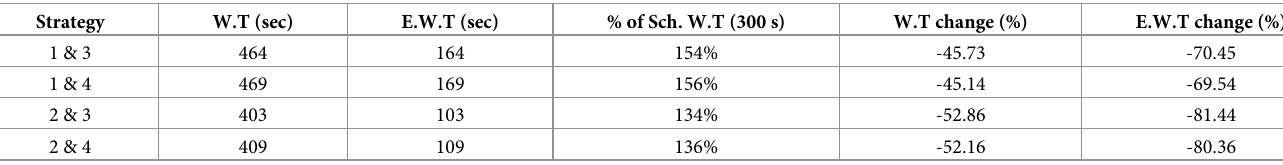
Table 16. Effect of combination of strategies on waiting